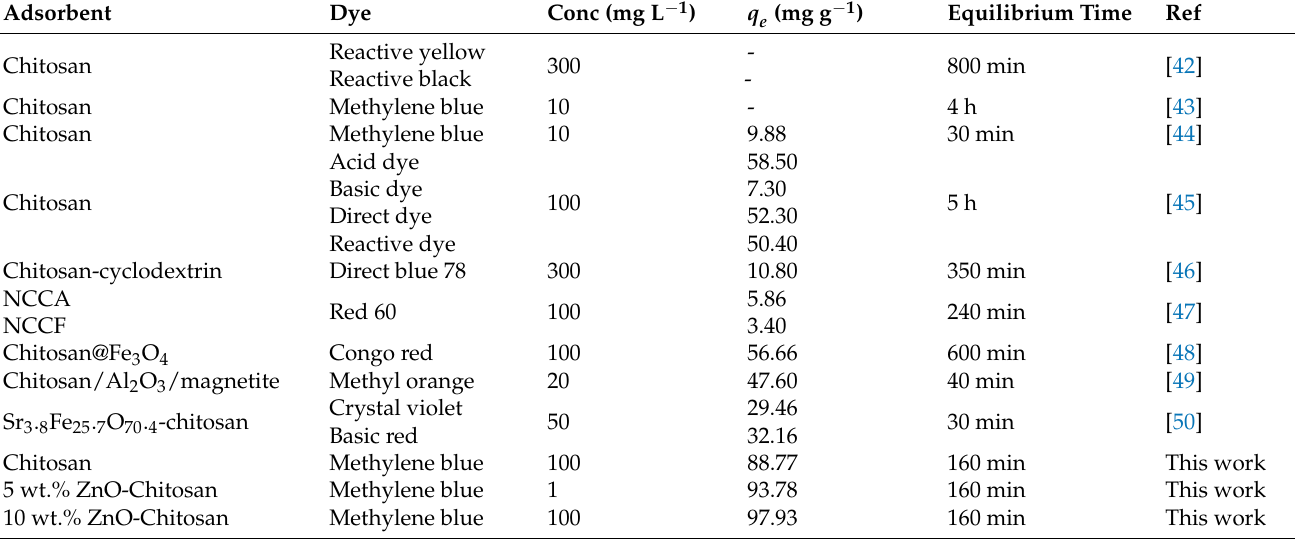
Table 4. Comparison of adsorption of various dyes onto chitosan and modified